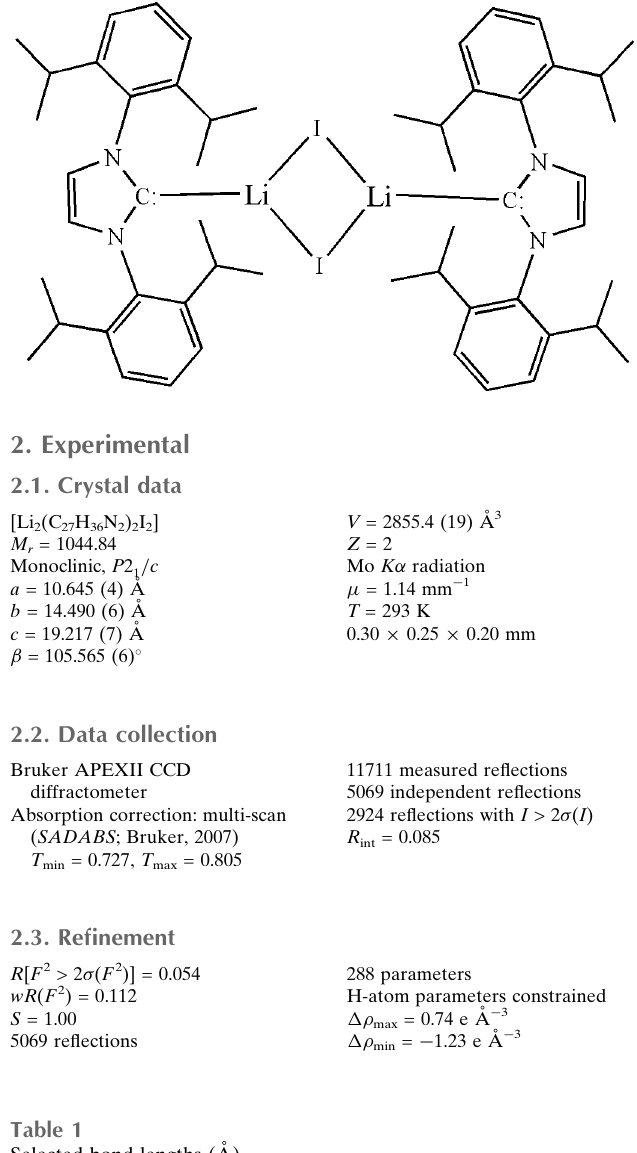
Selected bond lengths (A˚